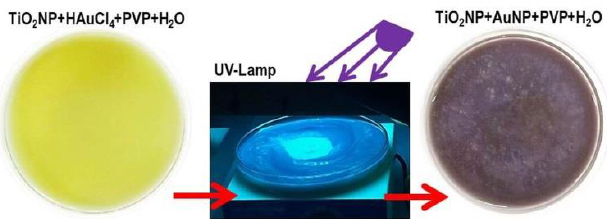
Figure 1. Functionalization of TiO 2 nanoparticles by UV-irradiation in a 0.1 M PVP (polyvinylpyrrolidone) aqueous suspension.